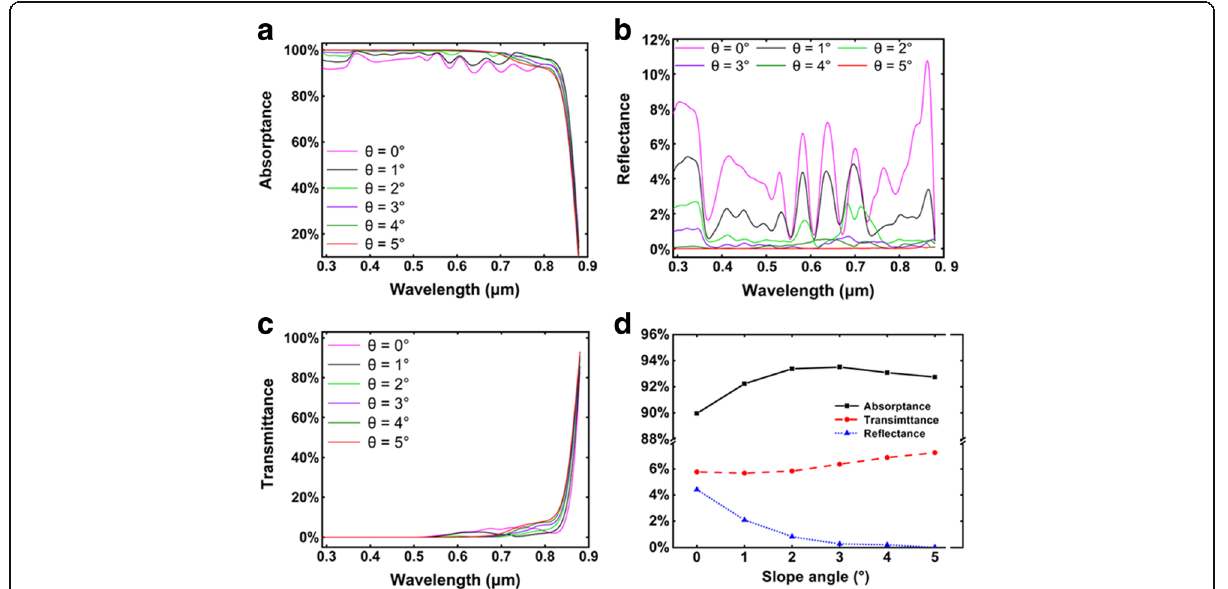
Fig. 2 a Absorptance, b reflectance, and c transmittance of the axial pin junction GaAs nanocone arrays with D / P = 0.5 and D = 0.18 μ m. d The AM1.5G-weighted integral of the absorptance, reflectance, and transmittance of the axial nanocone arrays with different slope